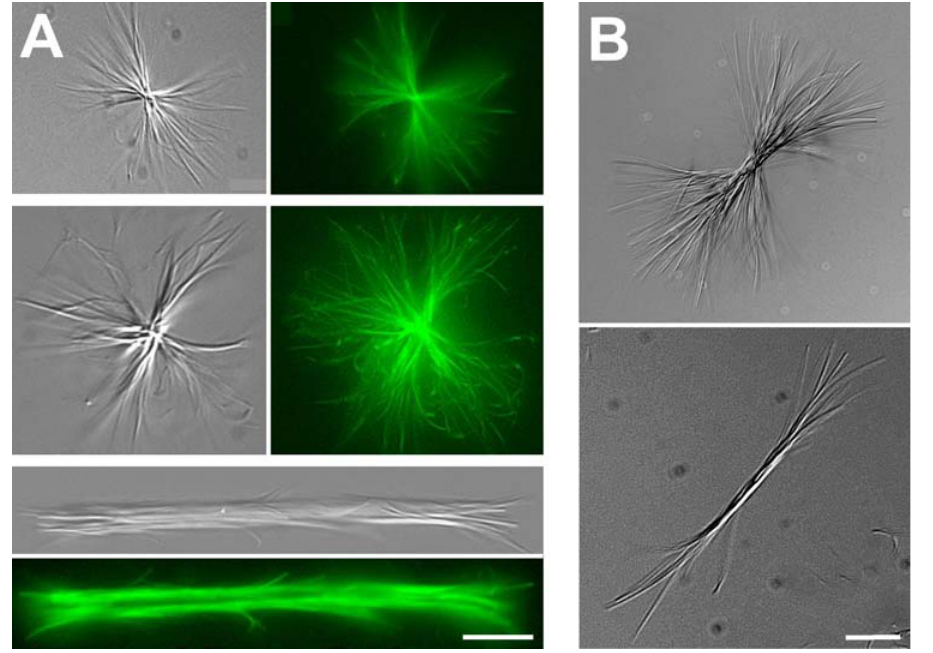
Figure 1. Taxol crystals resemble asters and bundles formed in the presence of Taxol-stabilized microtubules. (A) Two asters (top and middle) and one bundle (bottom) formed in the presence of Taxol and fluorescently labeled tubulin, as in text. Paired images with DIC (left) and fluorescent (right) optics. (B) DIC images of a Taxol crystal aster (top) and bundle (bottom), formed in the absence of tubulin. Bars, 10 m m.